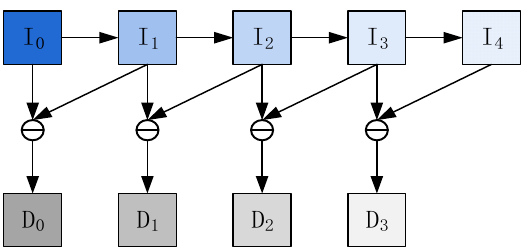
Figure 2. The generation of the multi ‐ scale contour features.